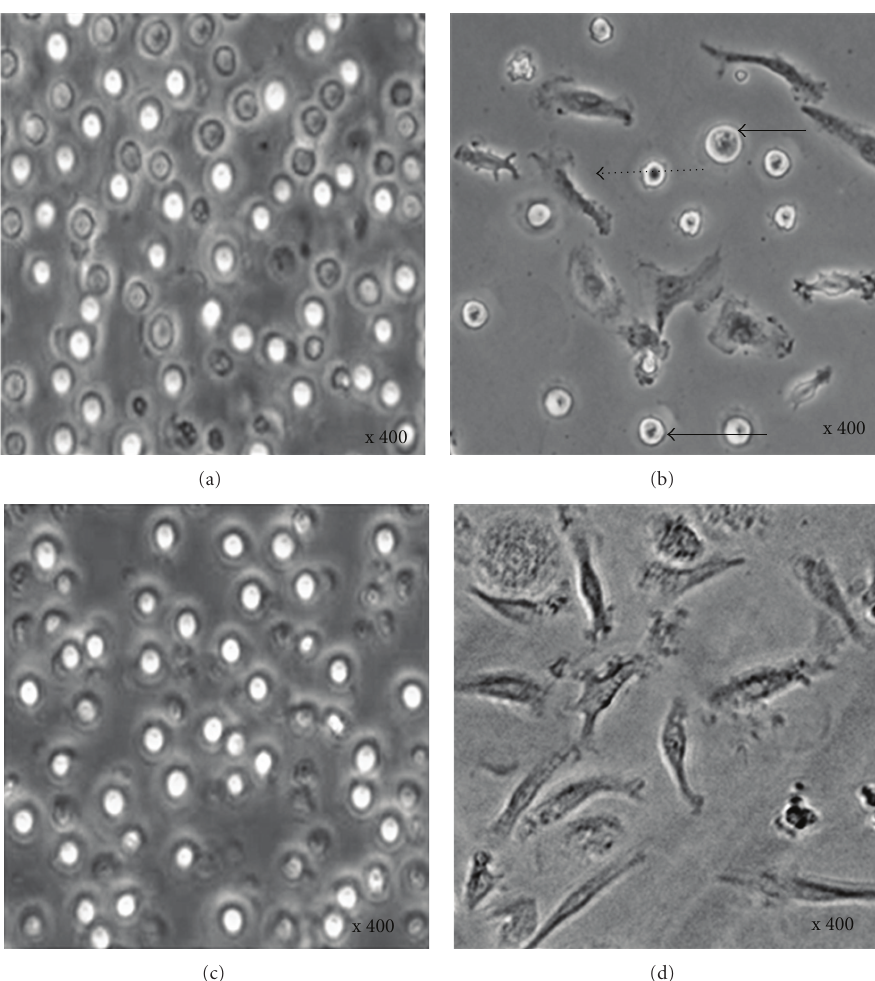
Figure 1: Human mononucleated cell morphology. (a) Mononucleated cells after isolation, (b) mononucleated cells after 7 days culture, (c) suspension cells, and (d) adherent mononucleated cells after 14-day culture. Each photomicrograph above is representative of three independent experiments ( × 200). Cells in suspension: the solid arrow. Adherent cells: the dashed